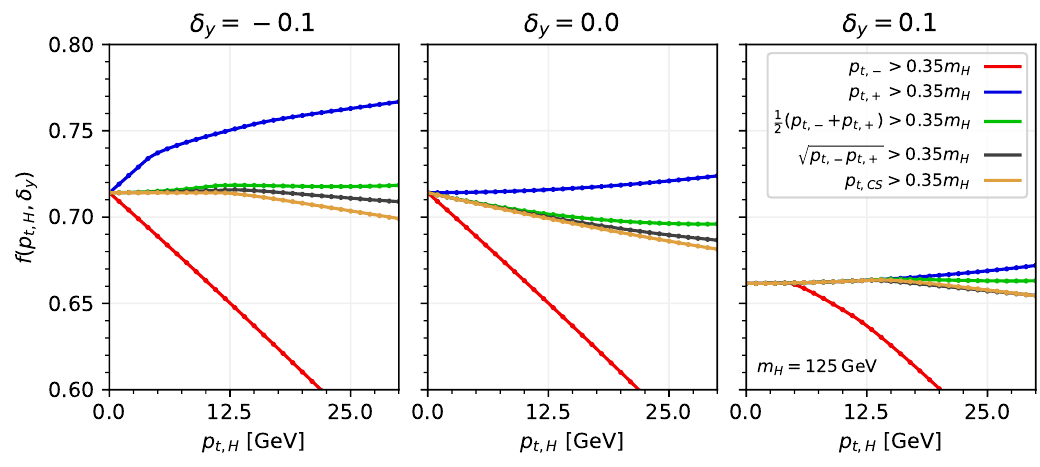
Figure 7 . Acceptance for a combination of a hardness cut (as specified in the legend) and a single photon rapidity cut. The quantity δ y is defined in eq. (4.12). For the hardness cuts that would normally have two separate hardness scales (i.e. all but the symmetric cut) we have set the lower cut to zero, so as to concentrate on the interplay between the harder cut and rapidity cut, as is appropriate in the region δ y (cid:28) ∆ /m h that we set out to study. The points, lines and bands follow the usual convention of figure